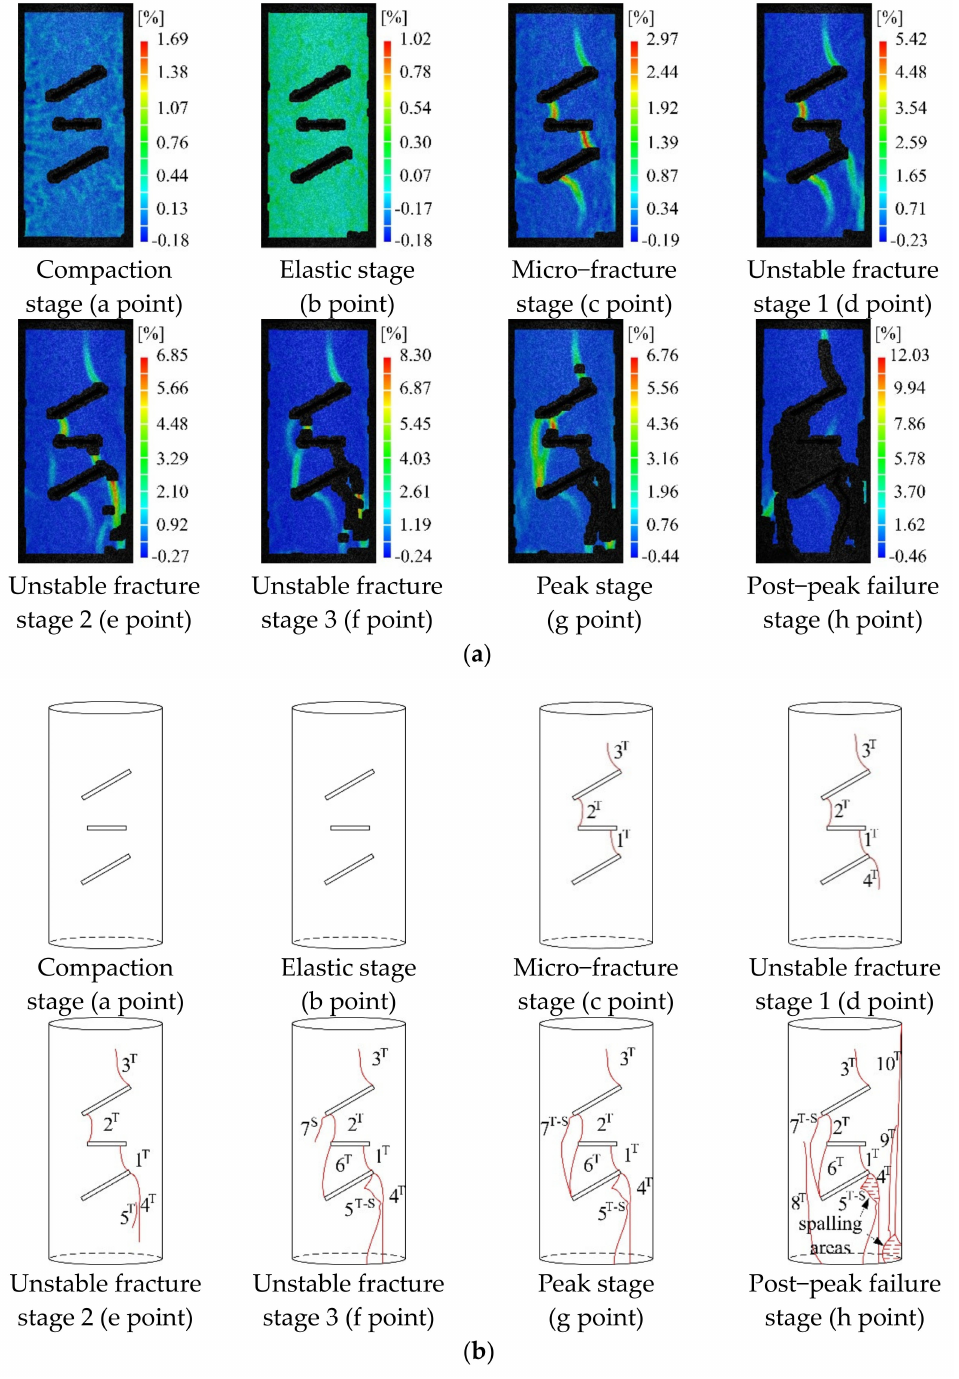
Figure 7. Principal strain nephogram and schematic diagram of crack propagation for specimen P − 30 − 1: ( a ) principal strain nephogram; ( b ) schematic diagrams of crack propagation on the